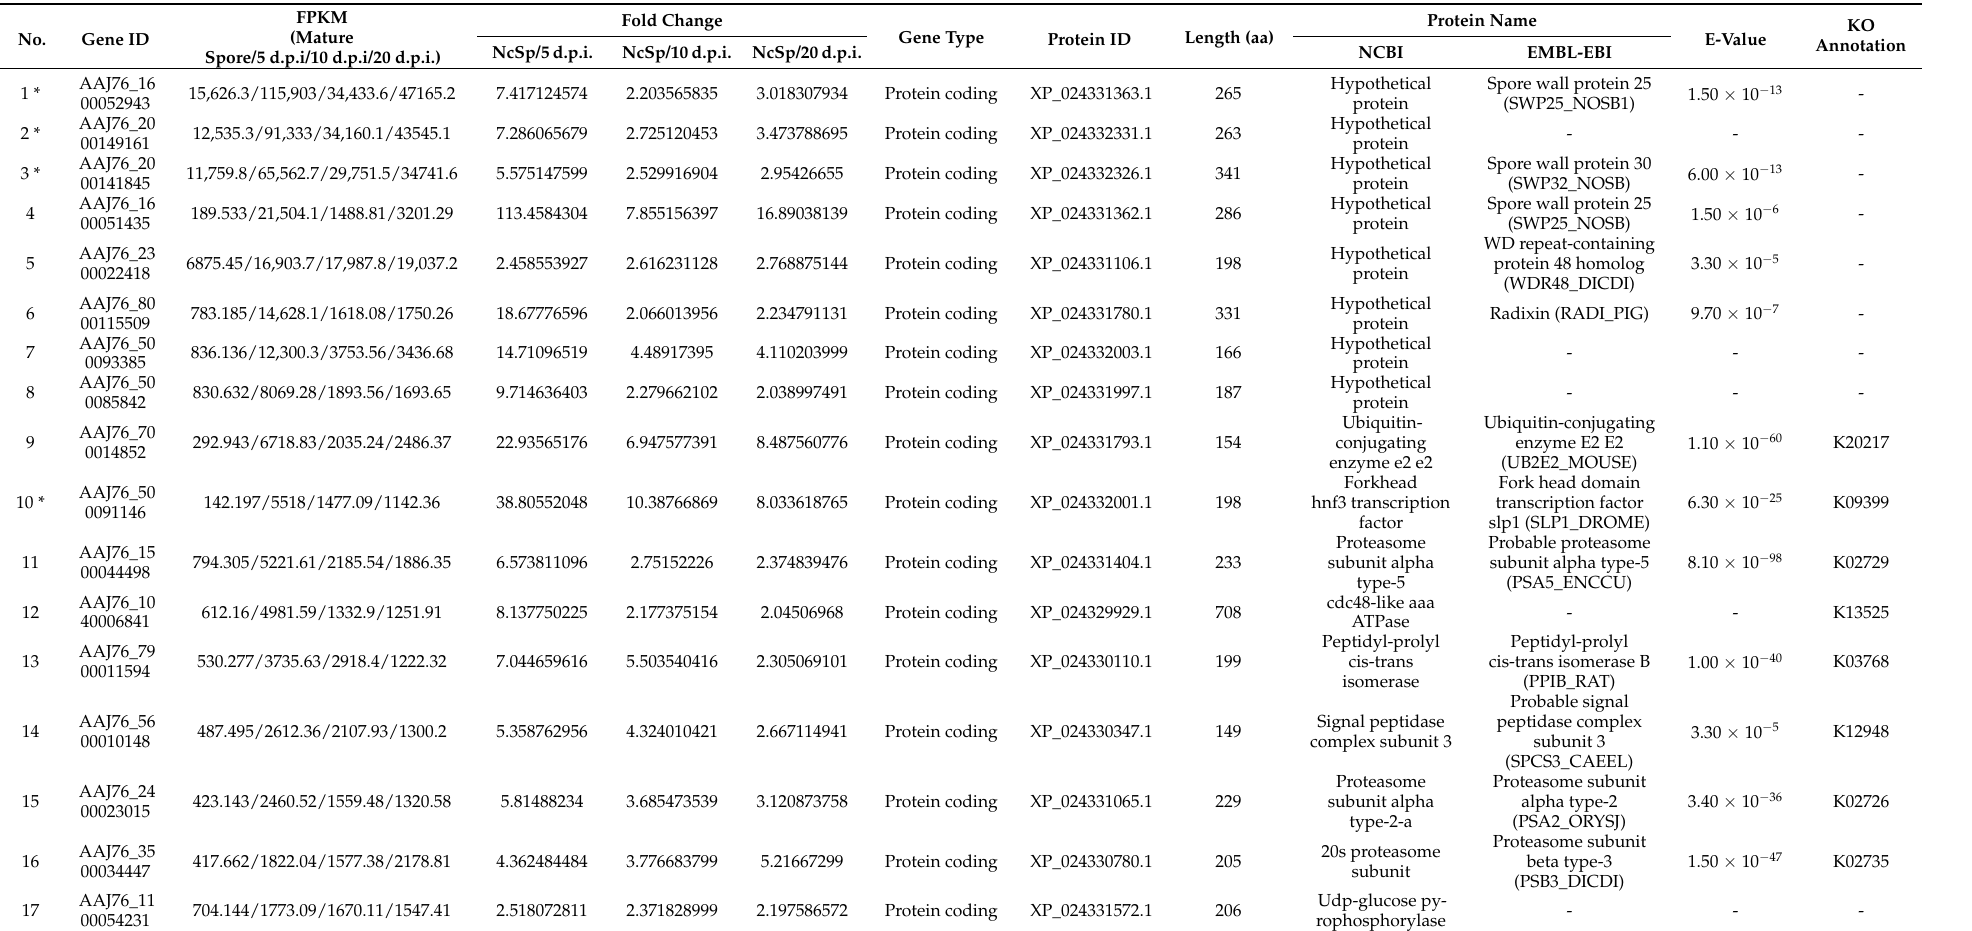
Table 1. List of upregulated common DEGs with FPKM values > 1000 at different times